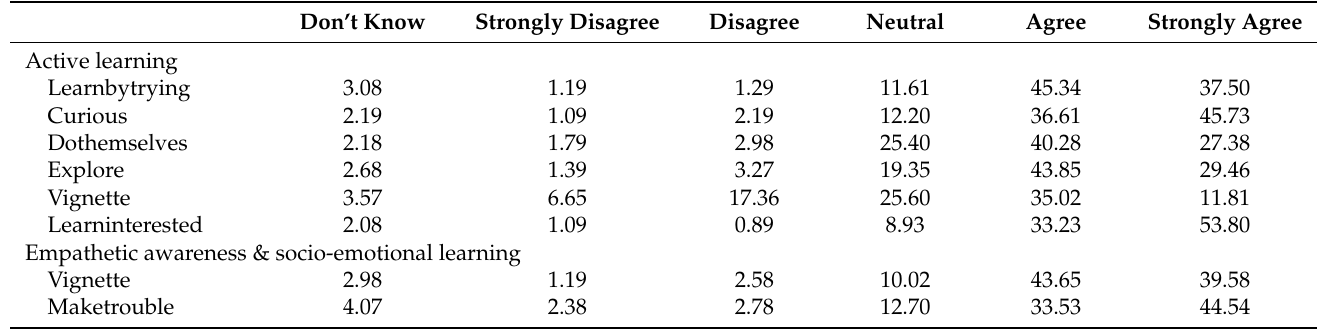
Table 2. Percentage of participants’ answers regarding their beliefs within each